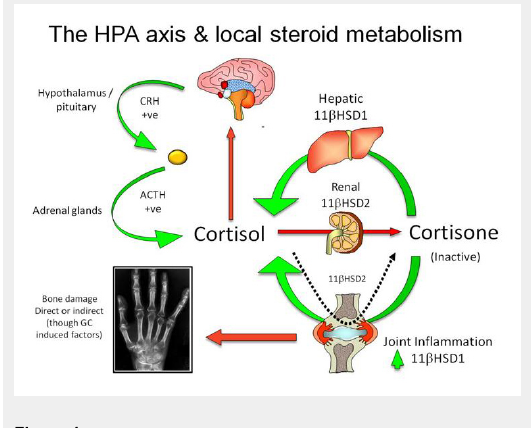
The integration of the local metabolism of cortisol within the liver, kidneys and inflamed tissues, with systemic regulation of circulating cortisol by the HPA axis. Hepatic 11β-HSD1 reactivates circulating cortisone, whilst renal 11β-HSD2 expression inactivates cortisol. During inflammation, elevated 11β-HSD1 expression within inflamed tissues amplifies the local cortisol concentration, which can result in detrimental side effects such as bone loss in inflammatory disease. Persistent 11β-HSD2 expression within specific leukocyte subsets during inflammation will confer steroid